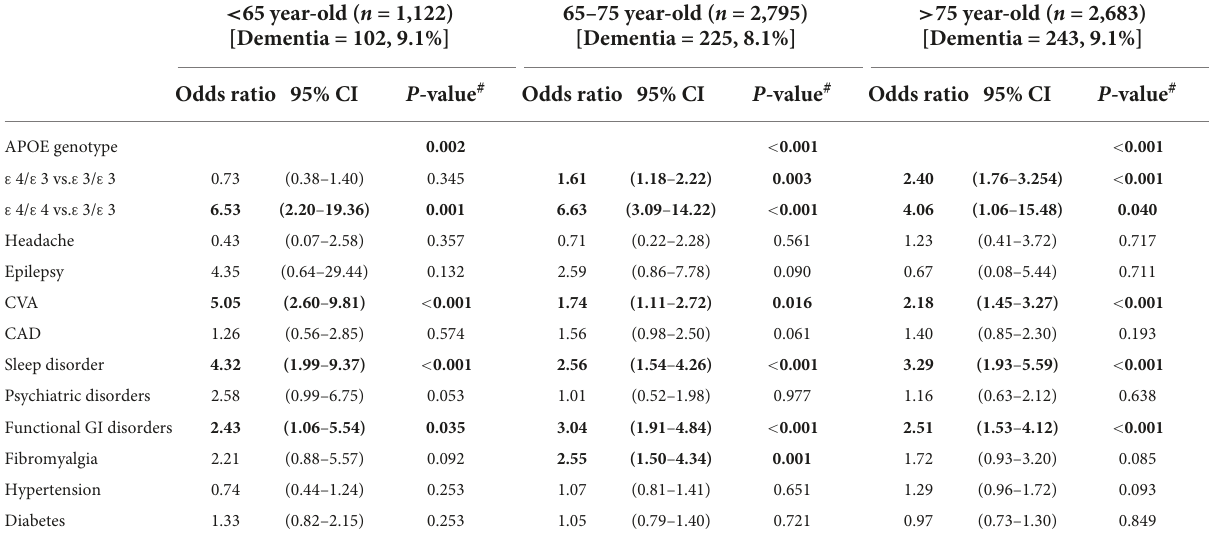
TABLE 3 Multivariate logistic regression predicts dementia development between 3 months and 3 years of presence of comorbidities in different age